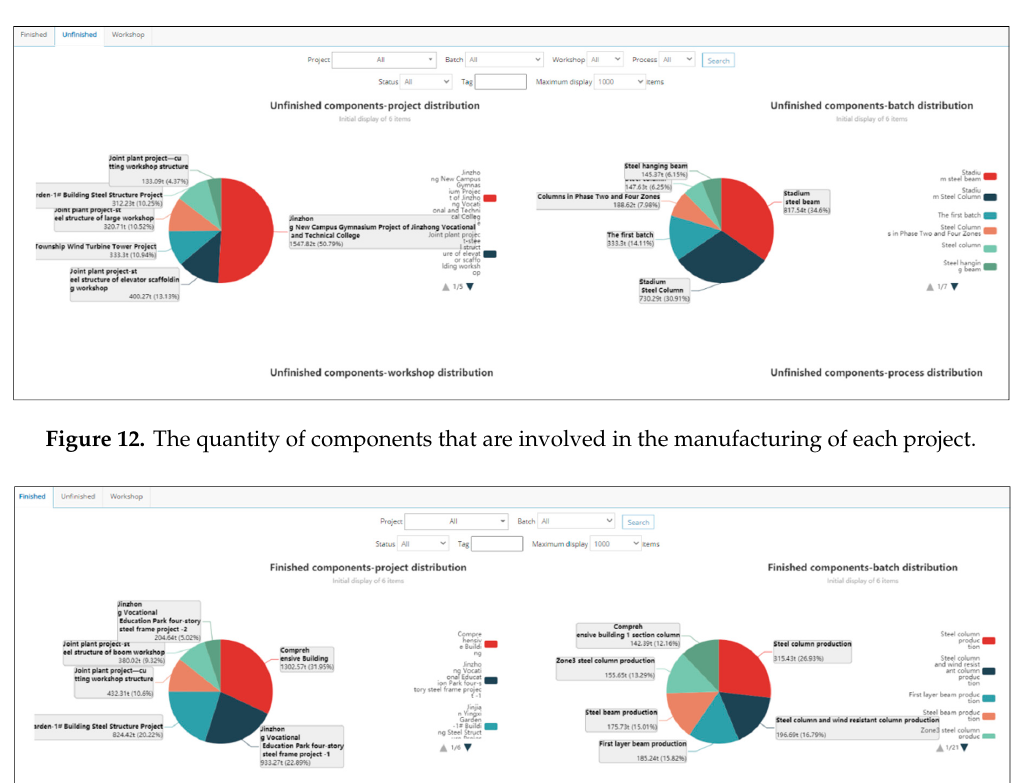
Figure 12. The quantity of components that are involved in the manufacturing of each project.